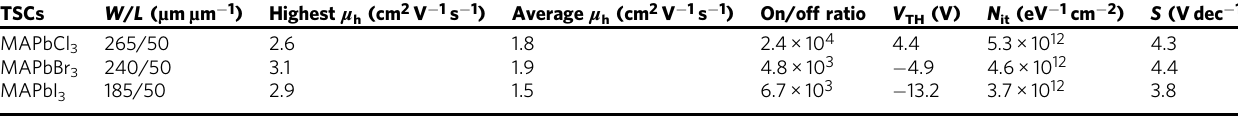
Table 1 The fi gures of merit of BGTC TSC-FET devices based on MAPbX 3 (X = Cl, Br, and